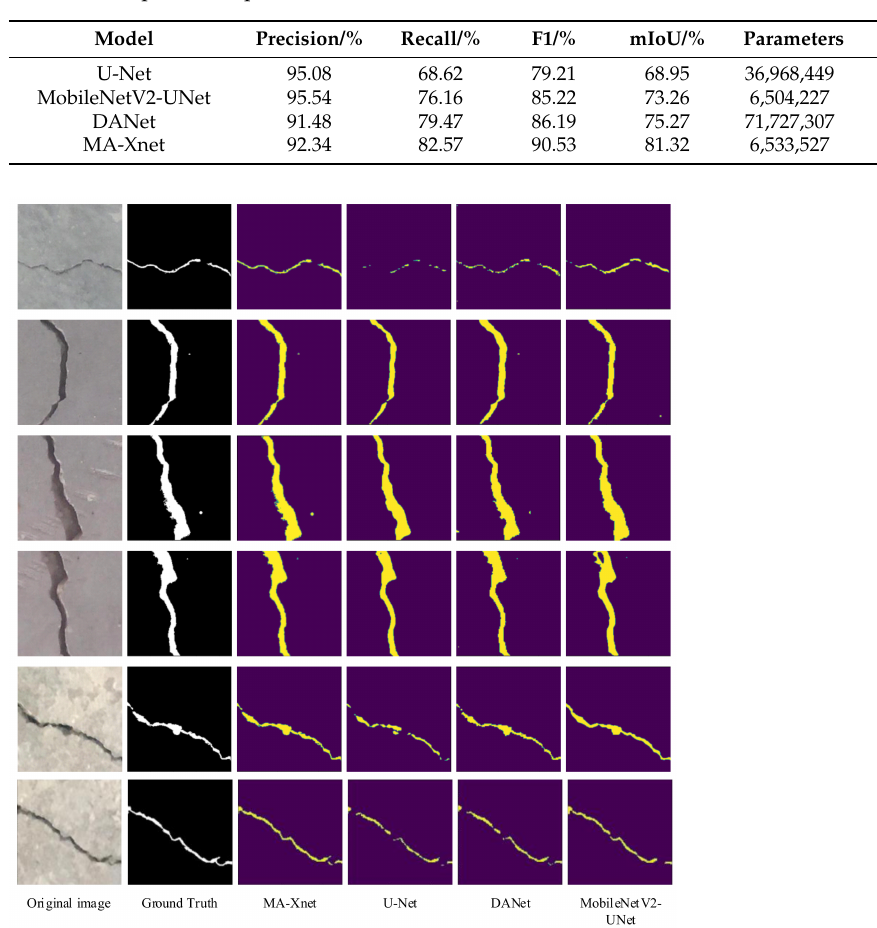
Table 2. Comparison experiment result table.